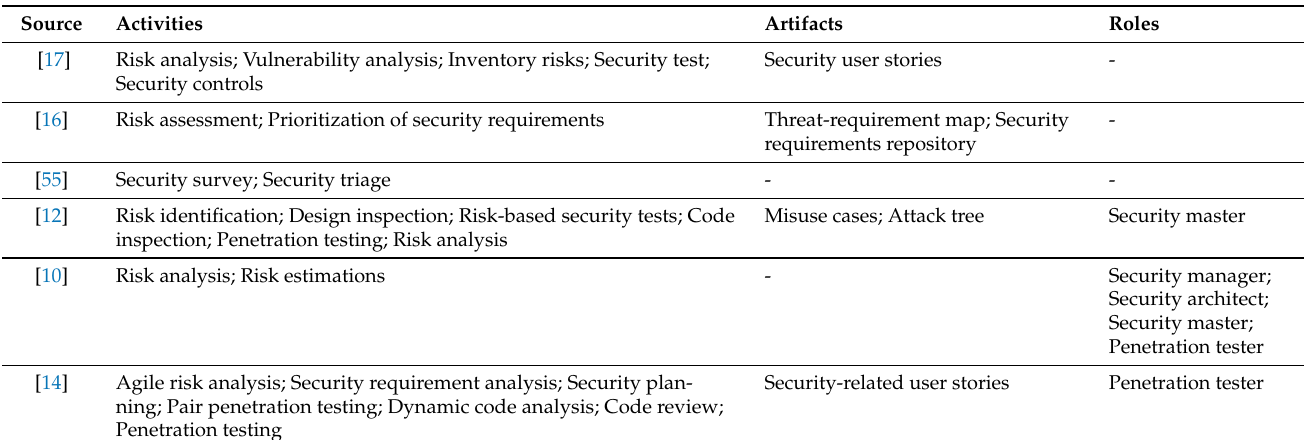
Table 1. Activities, artifacts, and roles found in the